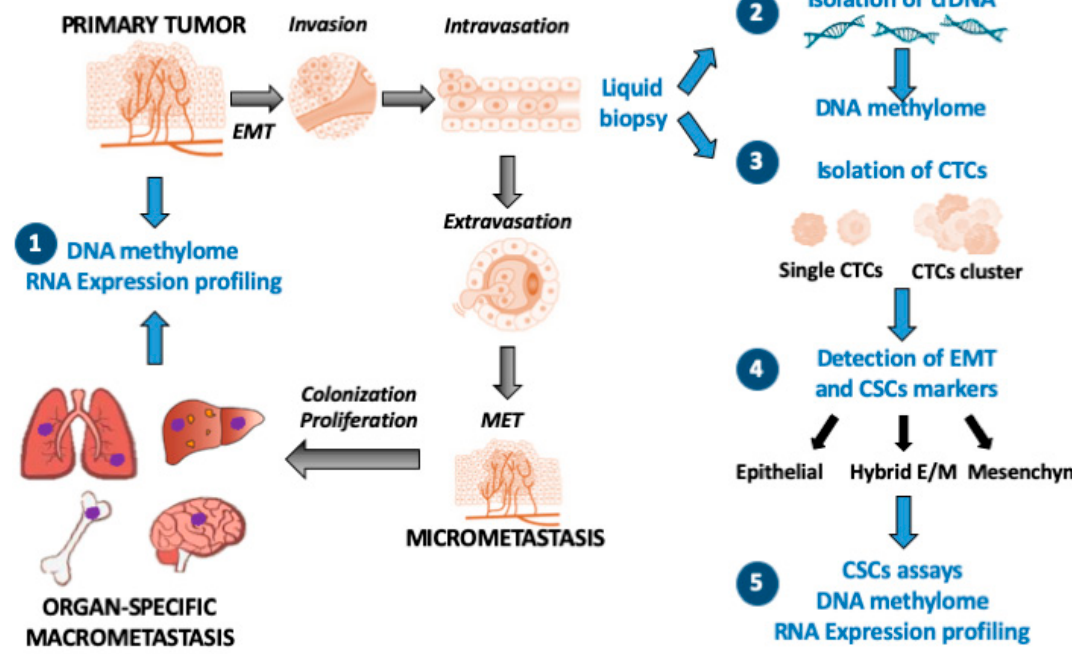
Figure 2. Scheme of the sequential steps of cancer cell dissemination from primary tumor to distant metastases. EMT indicates the Epithelial-to-Mesenchymal Transition required for the gain of invasive properties and anoikis resistance. MET (Mesenchymal-to-Epithelial Transition) refers to the reversion to the epithelial phenotype at sites of metastatic tumor growth. The numbers indicate various strategies for studying the changes of DNA methylation in the multistep metastatic process. (1) DNA methylome and RNA expression profiling in metastatic tissues vs primary tumor specimens; (2) liquid biopsy: DNA methylome analysis in circulating tumor DNA (in cfDNA extracted from blood